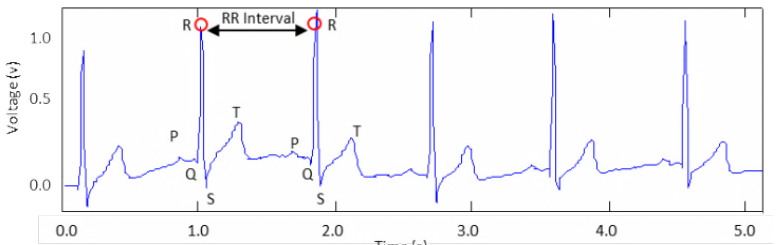
Figure 6. Peak detection of the ECG signal.